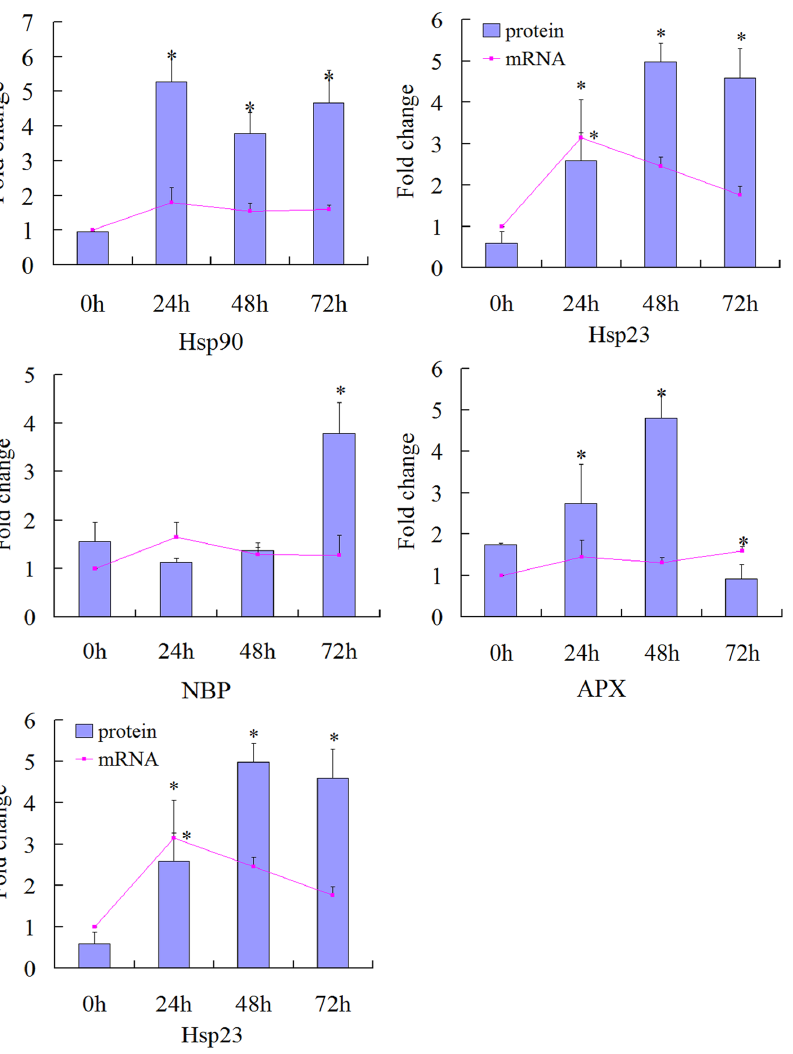
Figure 5. Test of the five differentially expressed proteins at mRNA levels by semi-quantitative analysis. The bars and curves represent fold changes (0, 24, 48 and 72 h at 40 u C) of protein and mRNA, respectively. The asterisk shows significant differences at P ,